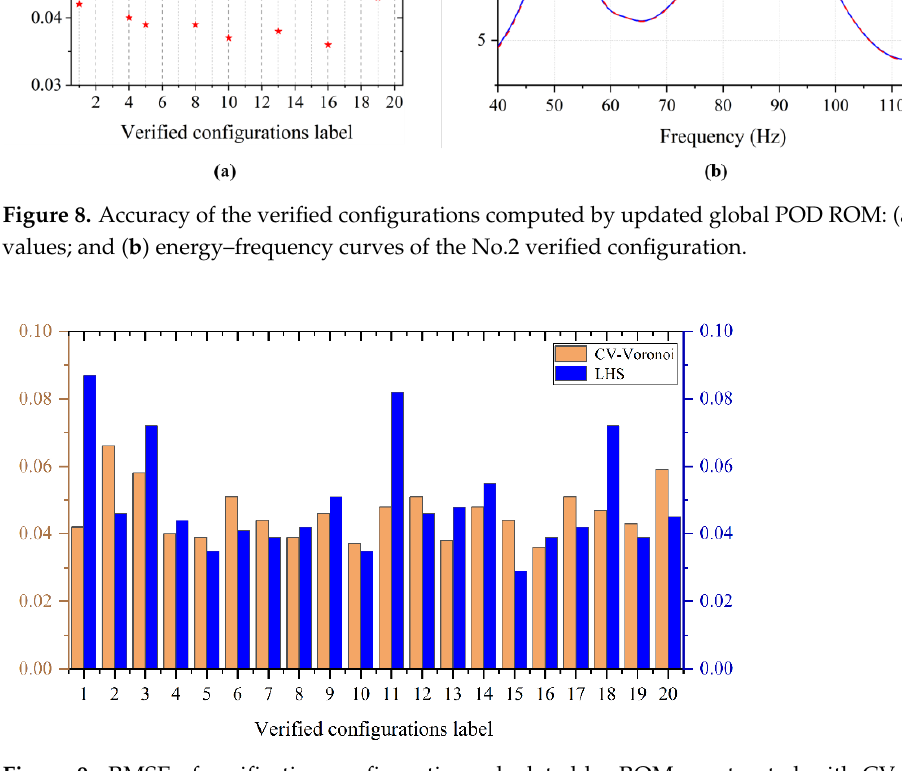
Figure 9. RMSE of verification configuration calculated by ROM constructed with CV – Voronoi sequence sampling and LHS direct sampling.